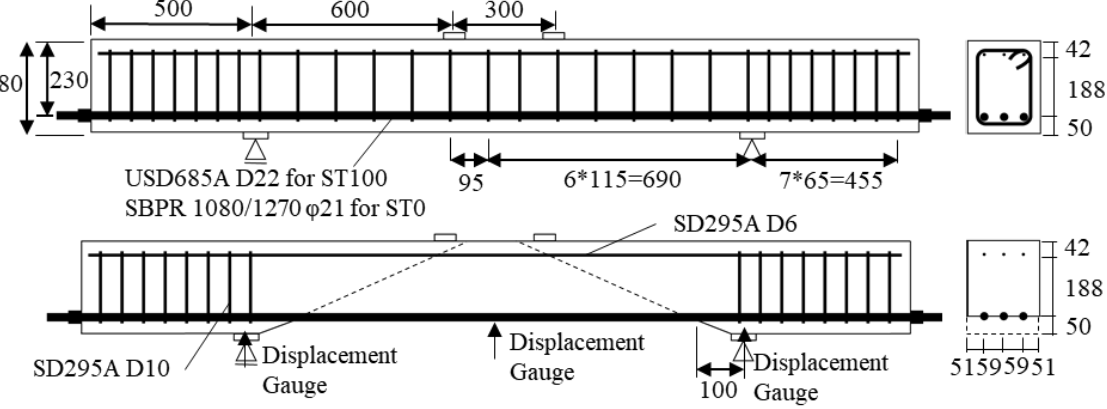
Figure 1. Specimen geometry (top: ST-0, ST-100 as examples, bottom: PL-50 as an example).